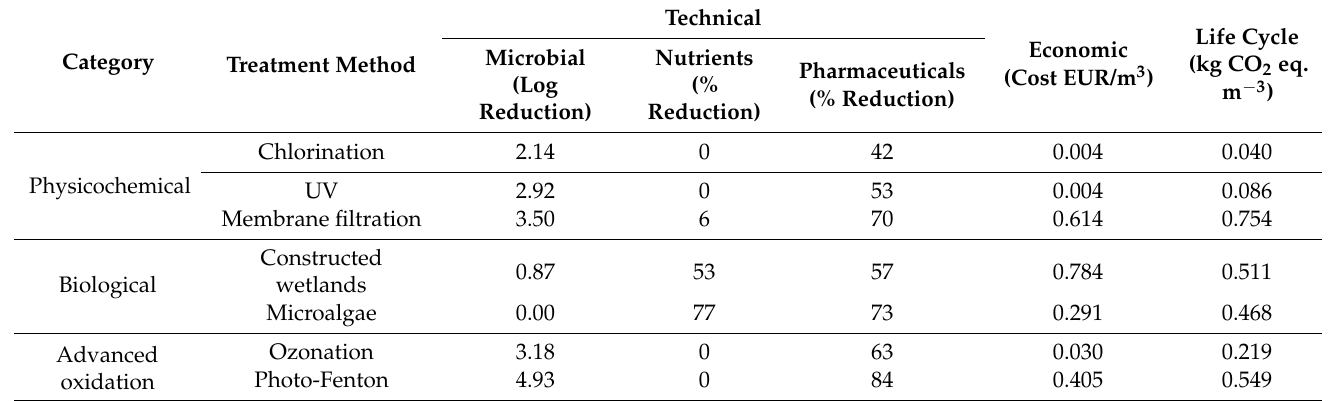
Table 1. Average technical economic and life cycle performances of the examined tertiary treatment